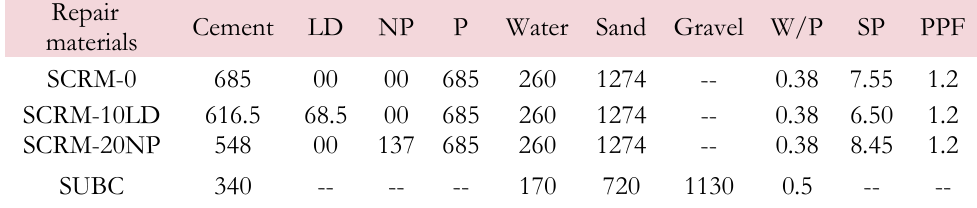
Table 2: Mixture proportions of SCRMs and SUBC (kg/m 3